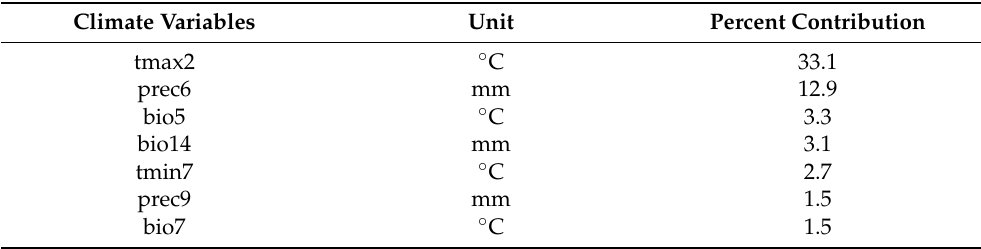
Environmental variables used in predicting the potential geographic distribution of S. juvencus